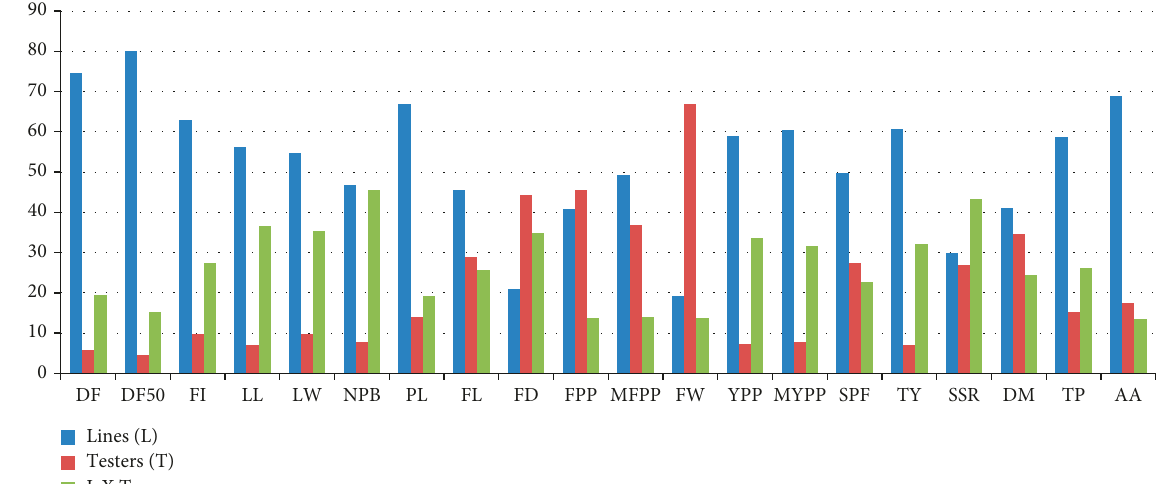
Figure 1: Relative contribution to the total variance by lines, testers, and line X